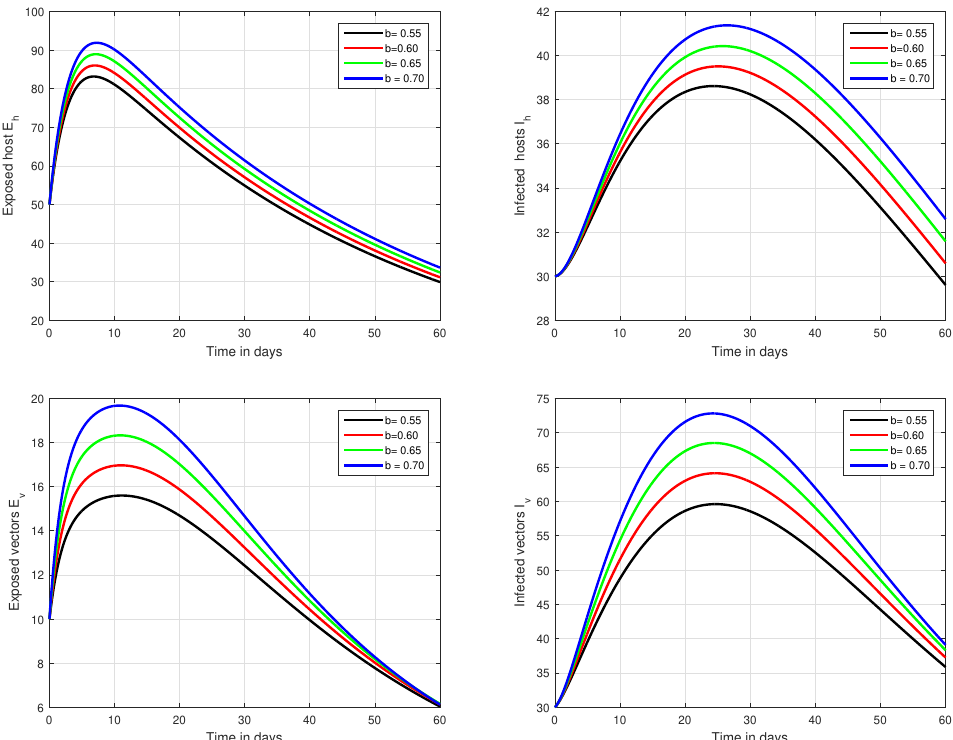
Figure 6. Illustration of the solution pathways of all the classes of our fractional model of Zika virus infection with various values of the input parameter b , i.e., b = 0.55,0.60,0.65,0.70.